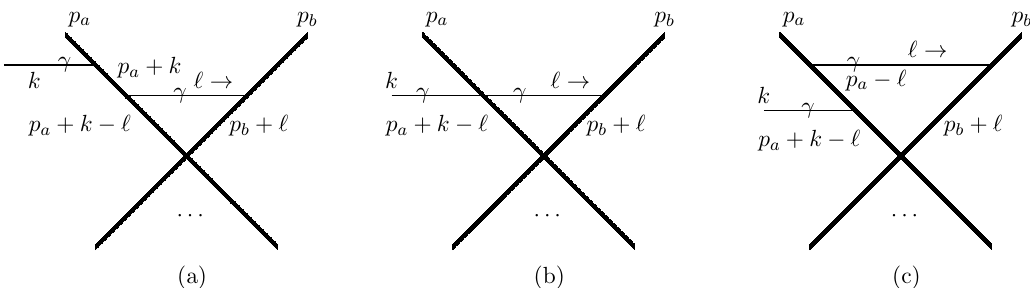
Figure 1 . One loop contribution to (cid:0) ( n; 1) involving internal photon line connecting two di(cid:11)erent legs. The thick lines represent scalar particles and the thin lines carrying the symbol (cid:13) represent photons. There are other diagrams related to this by permutations of the external scalar